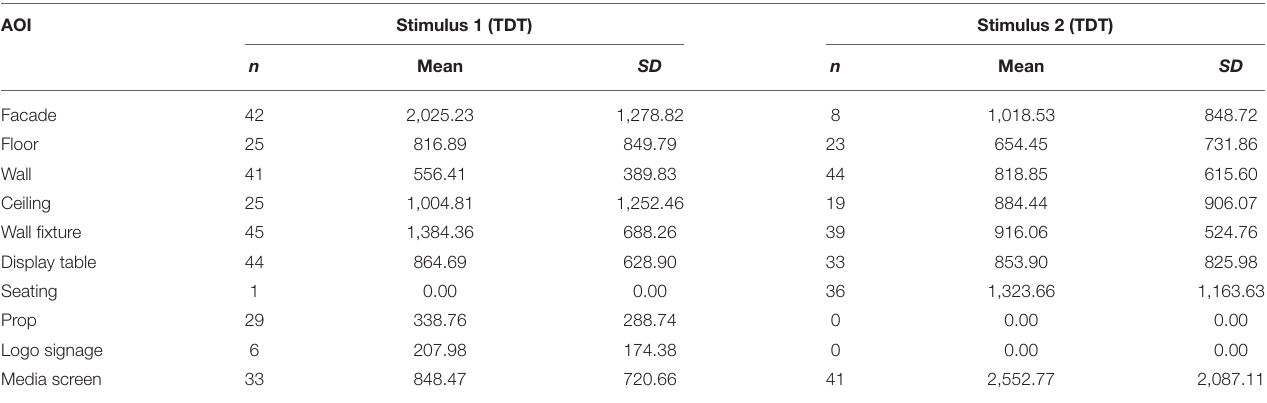
TABLE 1 | Means and standard deviations for total dwell time per